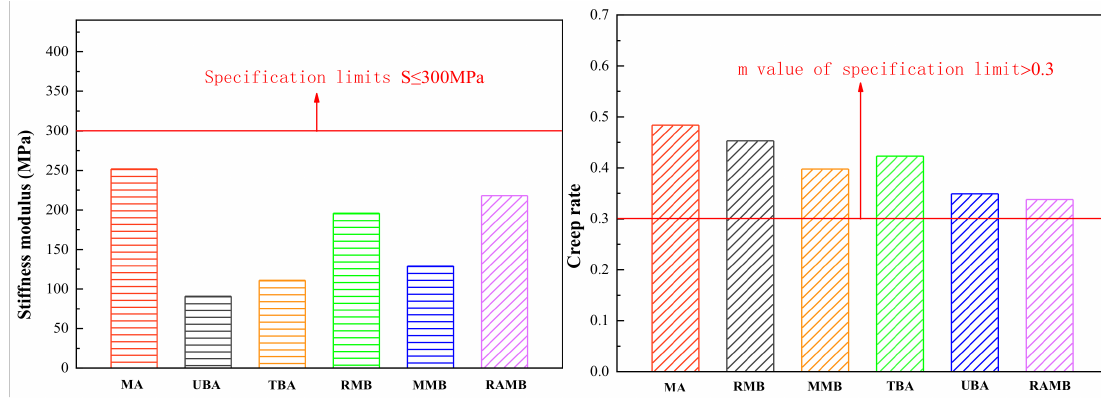
Figure 9. S and m of six asphalts at − 18 ◦